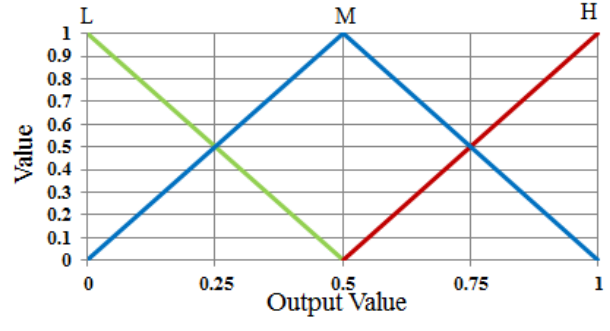
Figure 10. Output membership functions. Table 2. Fuzzy rules based on features 1 and 2.